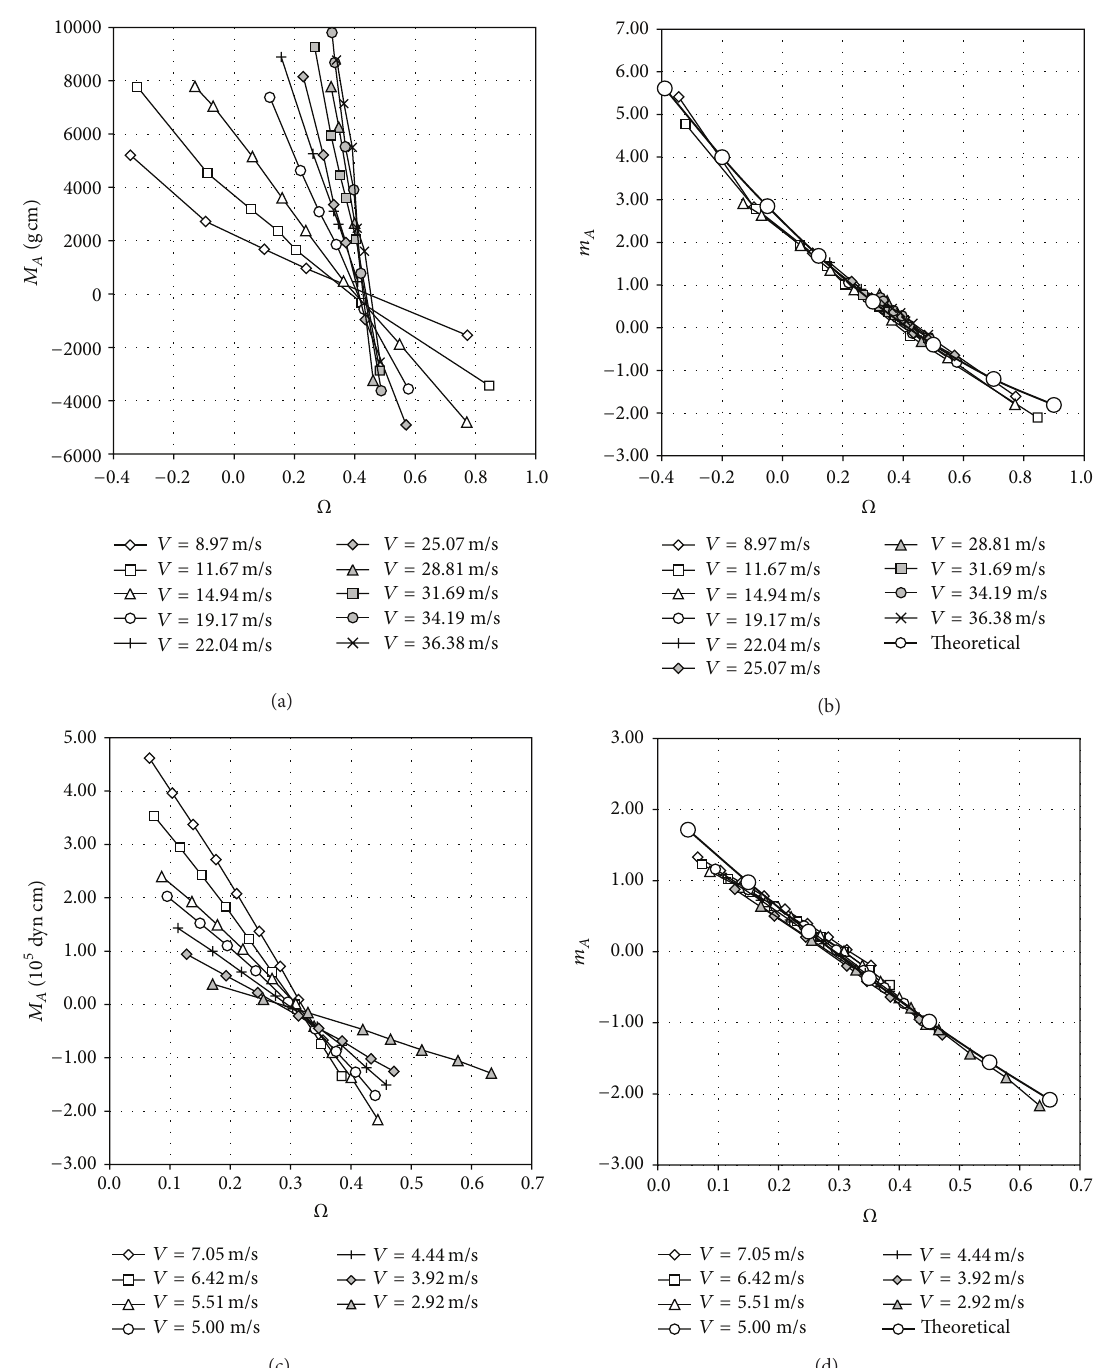
Figure 3: Aerodynamic torque, 𝑀 𝐴 , measured on 4-cup [27] (a) and 3-cup [13] (c) anemometers as a function of the ratio between the cup center velocity and the wind speed, Ω ( Ω = 𝜔𝑅 𝑟𝑐 /𝑉 ). The nondimensional torque, 𝑚 𝐴 , calculated for each curve, has also been included ((b) and (d)), together with the results from the classical theoretical model fitted to the curves; see expression